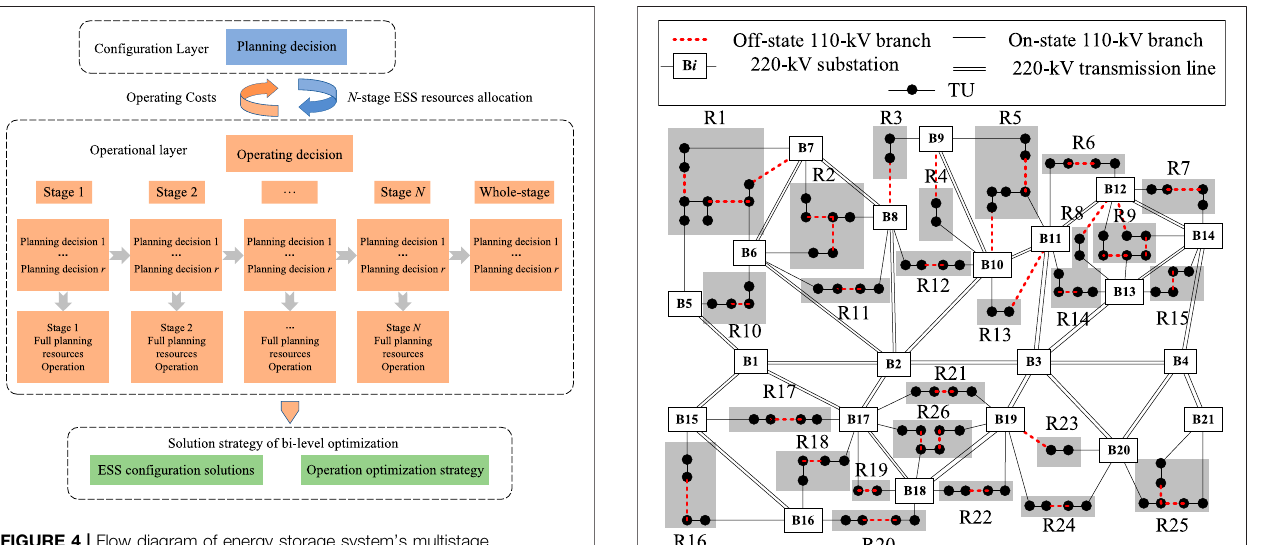
FIGURE 4 | Flow diagram of energy storage system ’ s multistage planning.